Question: Write a caption explaining this figure to a reader.
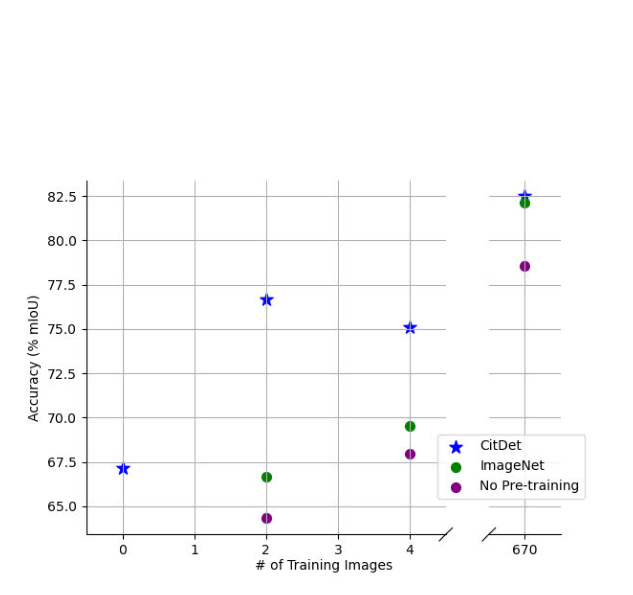
Answer: The mIoU performance on the MinneApple test set versus the number of training images used from the MinneApple training set. Standard pre-training methods are marked as dots, and our specialized pre-training is shown in blue stars. Our method achieves a better accuracy than traditional approaches, especially with only a few annotated images.